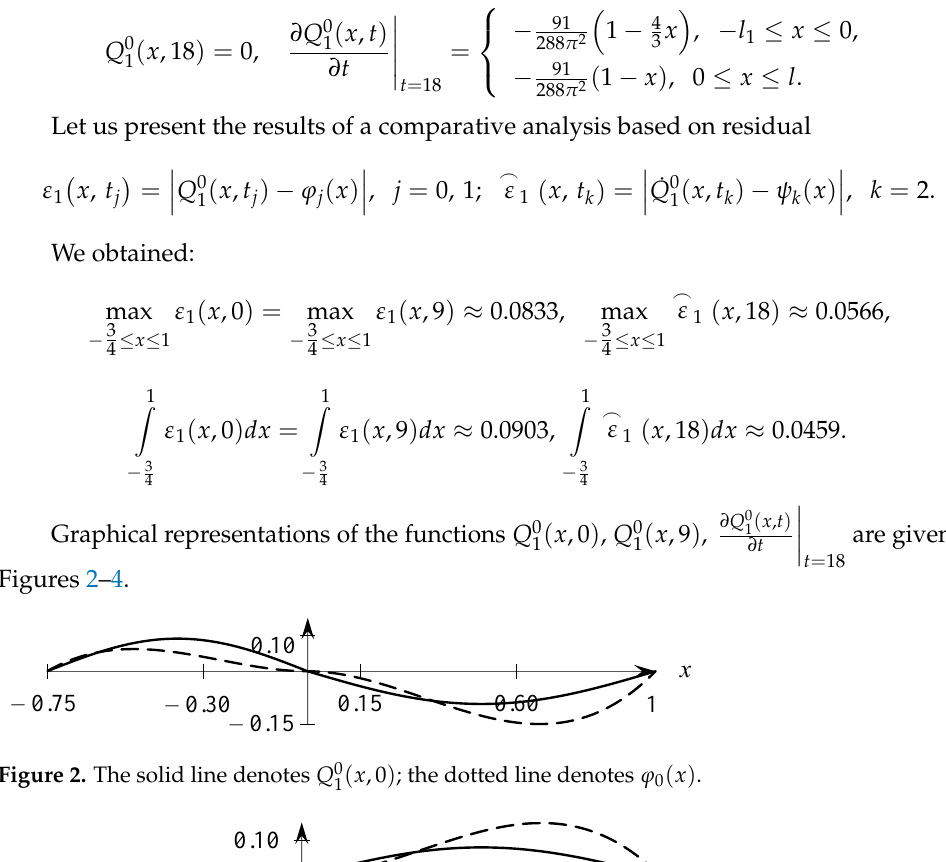
Figure 3. The solid line denotes Q 0